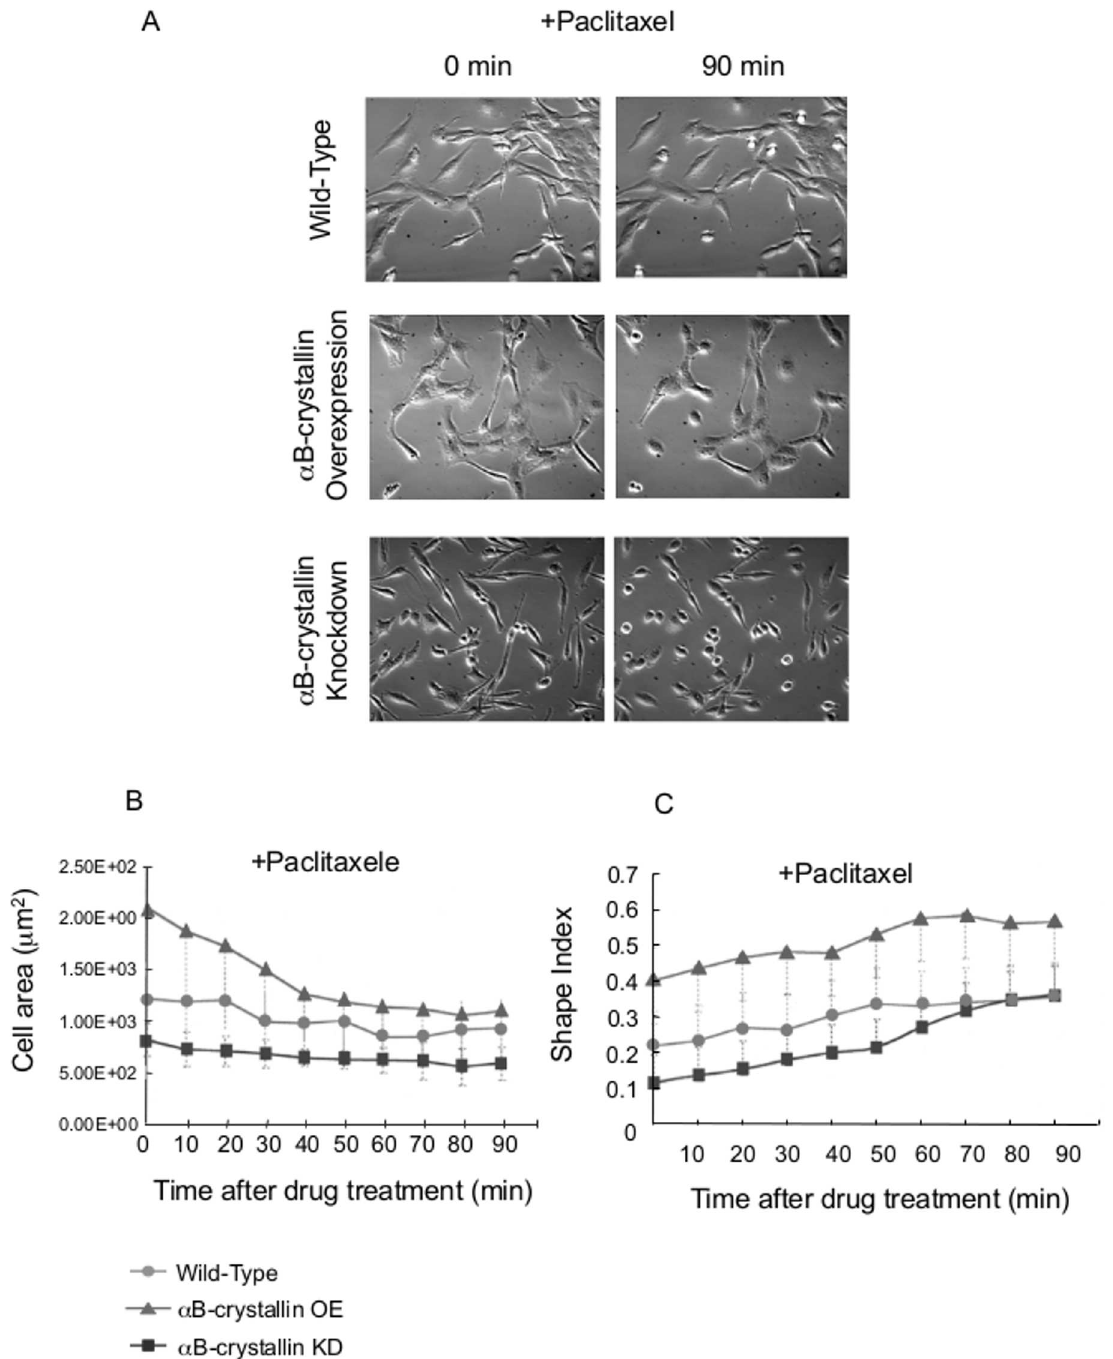
Fig 5. Effect of paclitaxel on α B-crystallin-overexpressing C6 cells and knockdown cells. Cell shapechange after paclitaxeltreatment. Just after the additionof drug (final 20 μ M; 0 min, left panel)and 90 min later (right panel)(A). Cell area (B) and Shape index (C) change of C6 cells after paclitaxeltreatment (final 20 μ M). N =